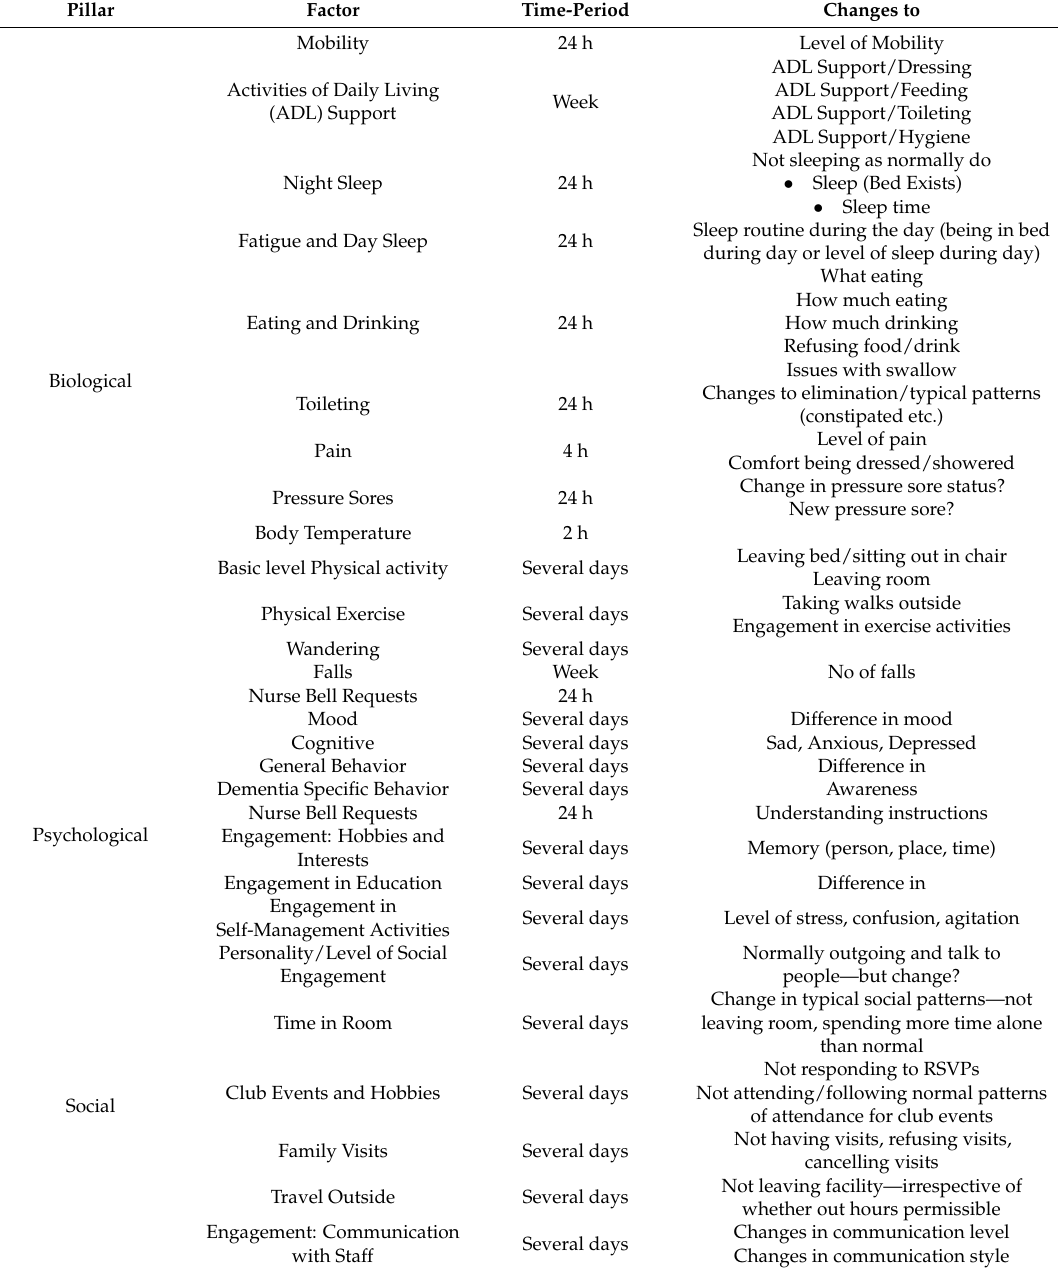
Table A3. Overview of study 1a